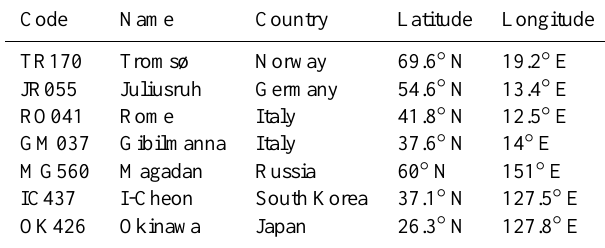
Table 1. Ionosonde stations used for the validation.